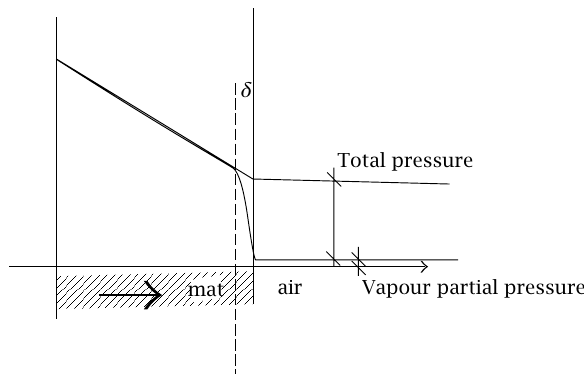
Figure 5.11 . Boundary layer in vapor partial pressure at external